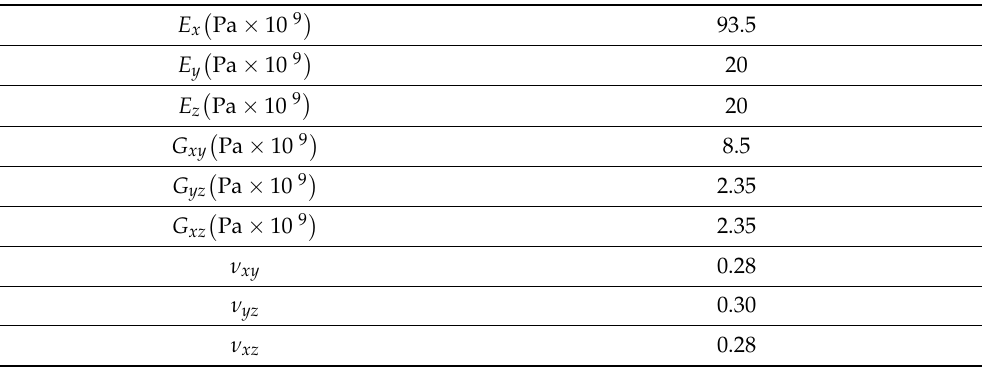
Table 1. BFRP composite structural properties.